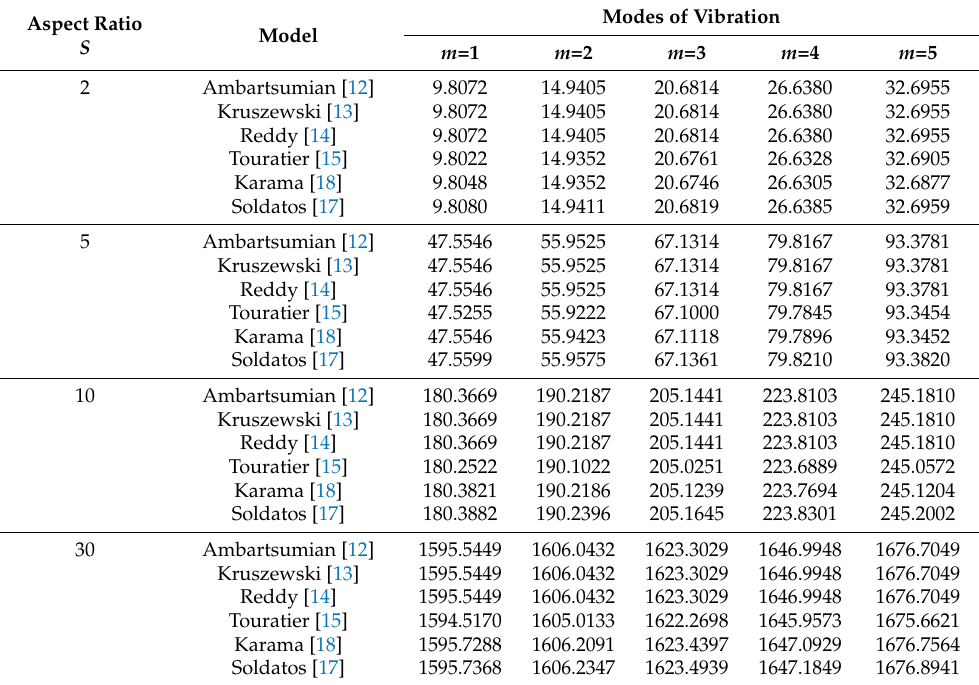
Table 7. Comparison of non-dimensional frequency of thickness shear mode ω ϕ of the piezoelectric beam for various modes of